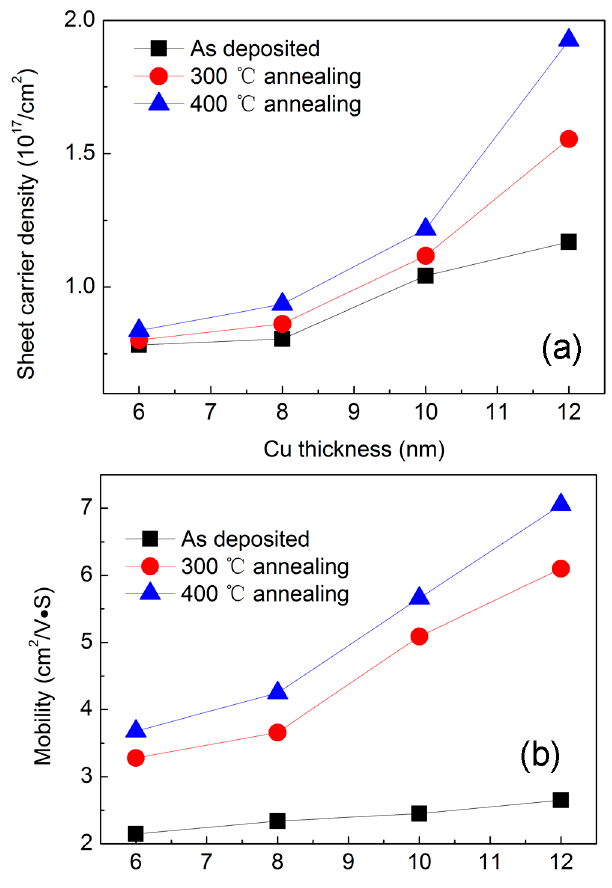
Figure 3. ( a ) Sheet carrier density and ( b ) mobility as a function of Cu thickness.